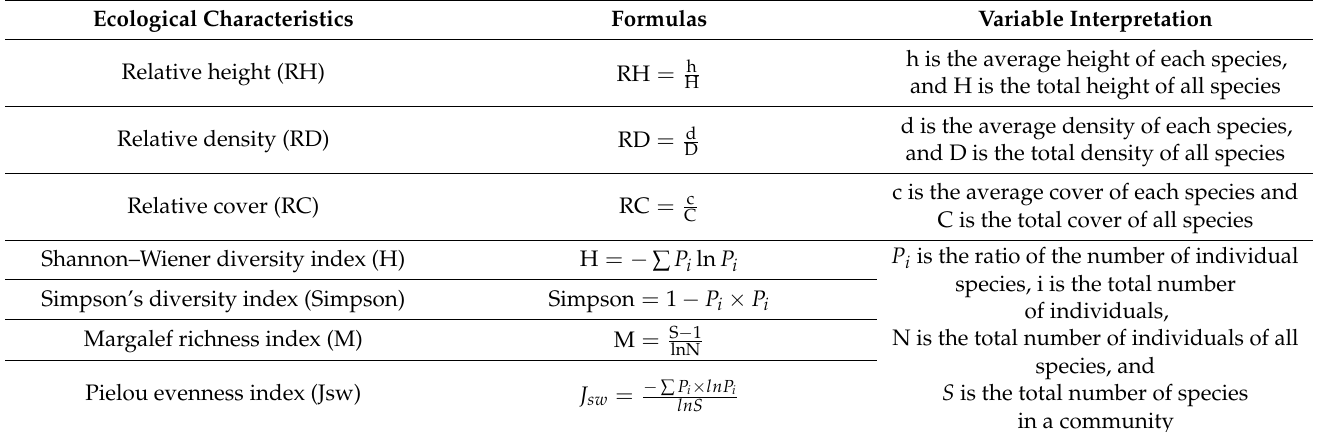
Figure 3. Map of field monitoring sites in the Tarim River Basin. Green points are groundwater monitoring wells. Table 1. Equations used to calculate the ecological characteristics of the plant